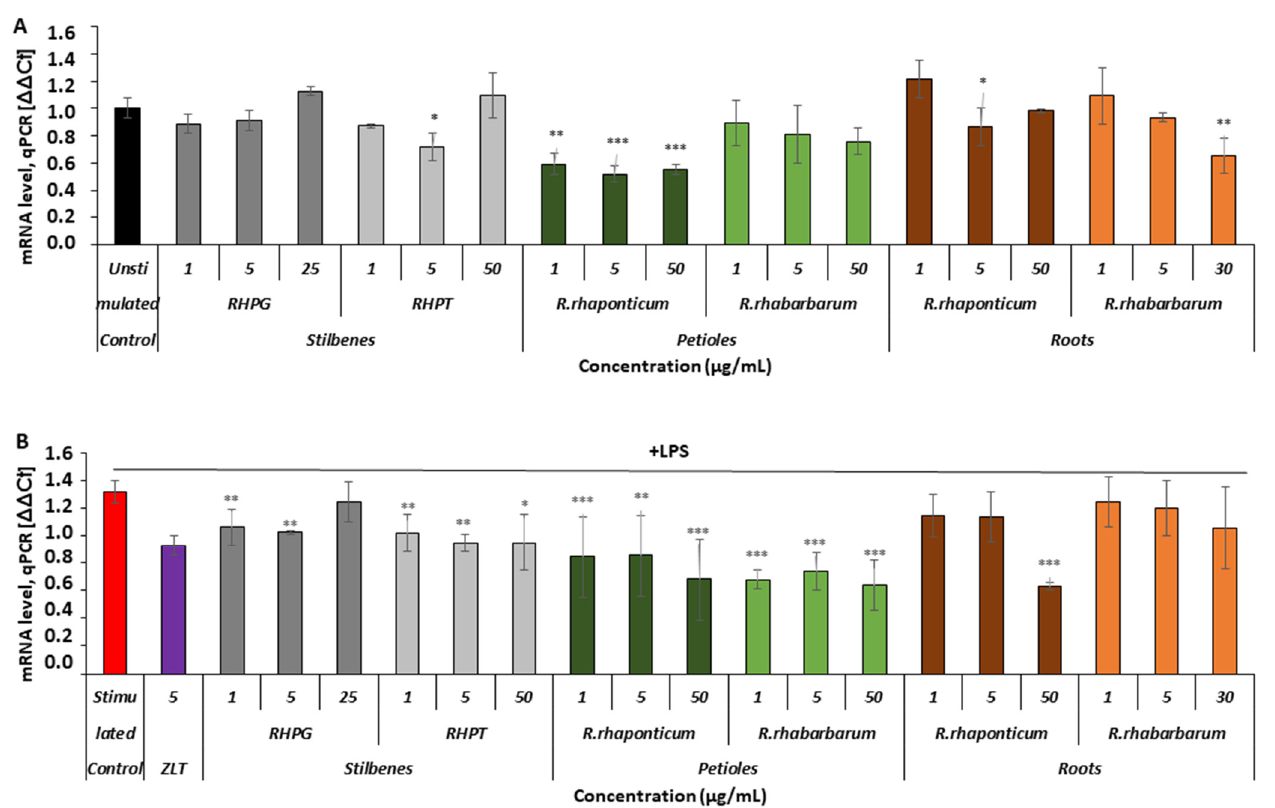
Figure 6. Effects of the rhubarb extracts and stilbenes on ALOX5 gene expression in unstimulated and inflammatory-activated HUVECs. Panel ( A )— ALOX5 gene expression in HUVECs treated with stilbenes (RHPG and RHPT) or rhubarb extracts, without subsequent pro-inflammatory stimulation with LPS. Panel ( B )— ALOX5 gene expression in HUVECs pre-incubated with stilbenes (RHPG and RHPT) or rhubarb extracts, and stimulated with LPS; n = 5; (* p < 0.05; ** p < 0.01; *** p < 0.001). ZLT -zileuton, a reference compound (5-LOX inhibitor).